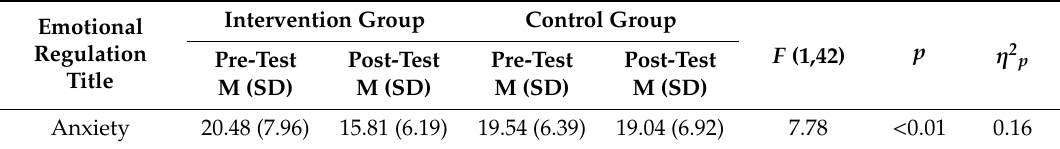
Table 5. Anxiety (Anxiety and Resilience Questionnaire, QAR).